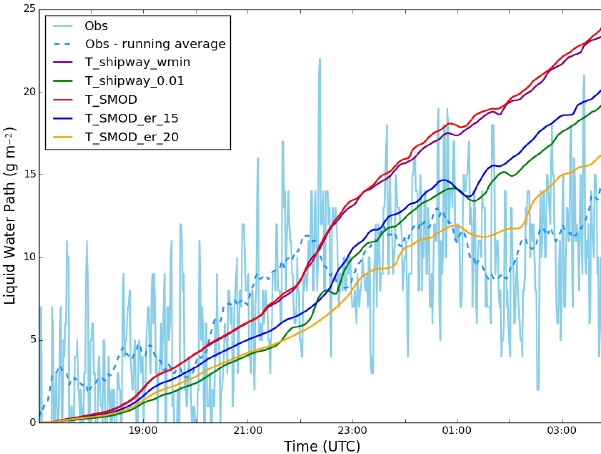
Figure 5. (a) Time series of the surface deposition